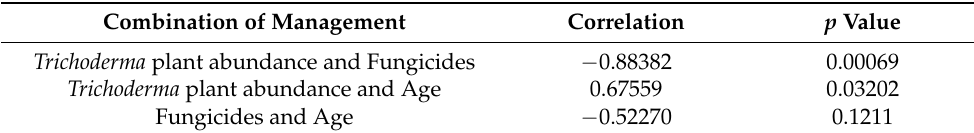
Table 5. Pearson’s product-moment correlation. 95 percent confidence interval (data in bold means significant differences).